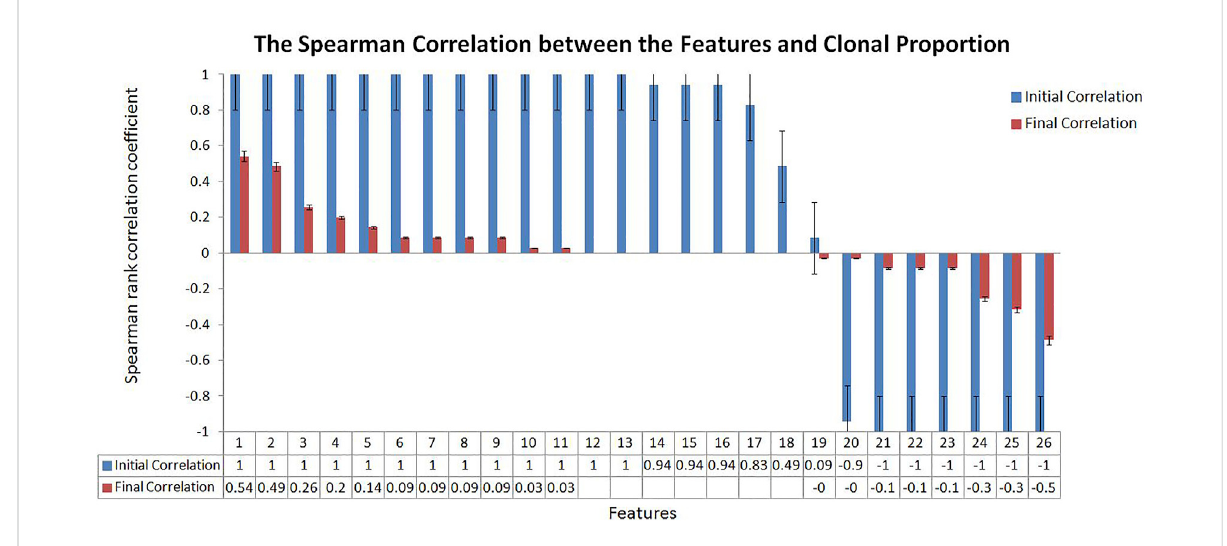
FIGURE 2 The Spearman Correlation between the Features and Clonal Proportion. According to the Spearman correlation coef fi cient of sequencing signal and the diluted sequencing signal, it can be seen that most of the signals have strong correlation with the clonal proportion (Initial Correlation in Blue). The results showed that the correlation coef fi cient between the transferred features and sample purity was signi fi cantly reduced (Final Correlation in